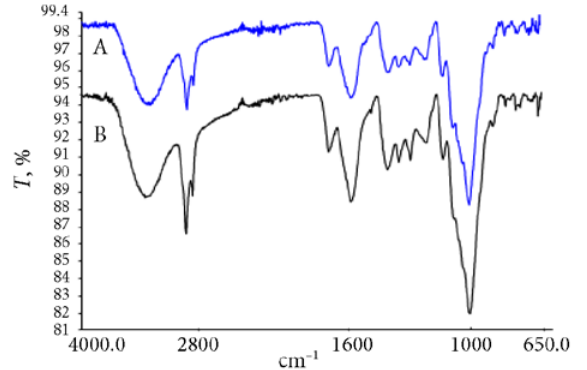
Fig. 1. (a) FT-IR spectrum of tobacco leaf after biosorption and (b) FT-IR spectrum of tobacco leaf before biosorption